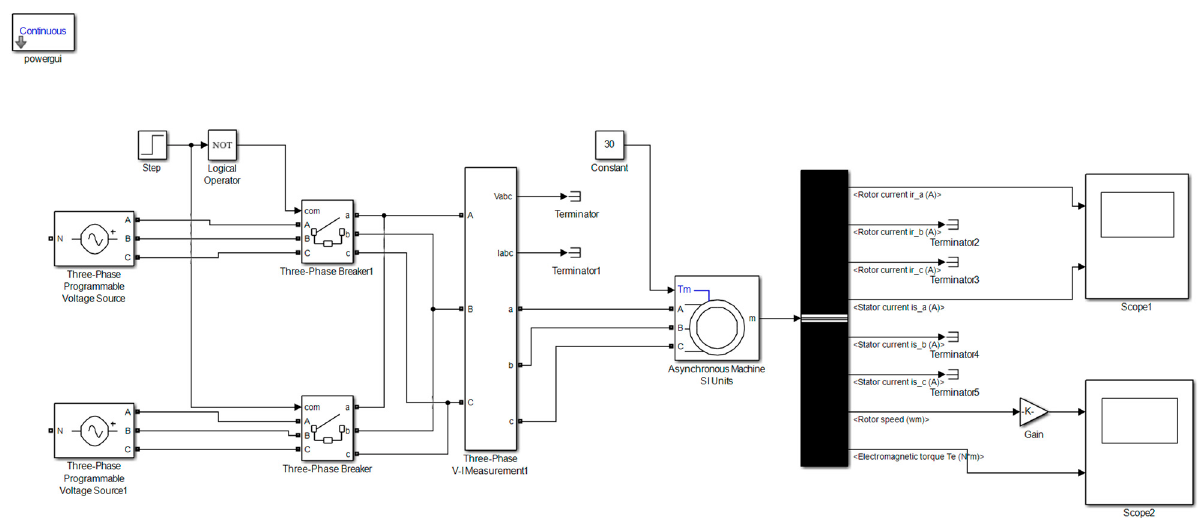
Figure 9. Inverter induction motor simulation model.